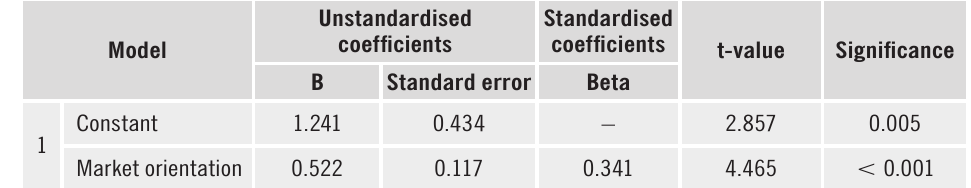
Table 11. Coefficients: the level of market orientation and competitiveness index